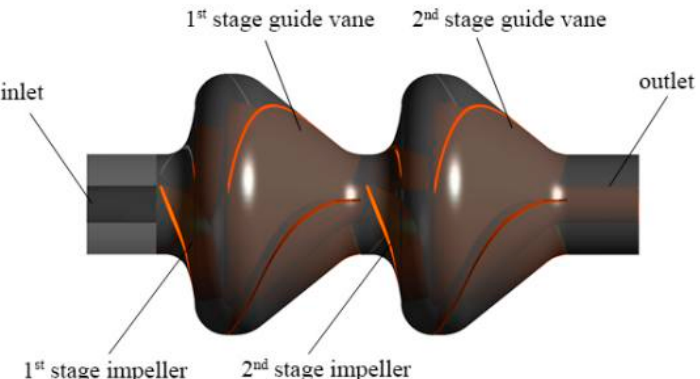
Table 1. Geometric parameters of model pump impeller.